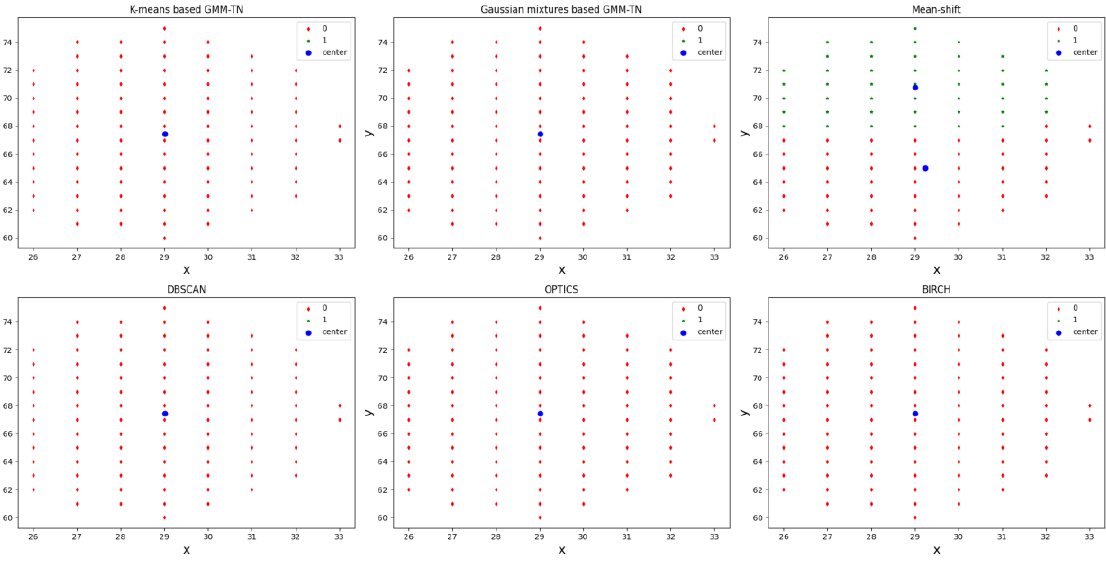
Figure 17. Automatic target number estimation results (double overlapped targets) using K-means- based GMM-TN, Gaussian-mixtures-based GMM-TN, Mean-shift, DBSCAN, OPTICS, and BIRCH. According to the two cases results, we find the GMM-TN algorithm developed in this paper can provide accurate automatic target numbers, either using the K-means or the Gaussian mixtures clustering. Their centroids are somewhat different. However, the Mean-shift and BIRCH algorithms tend to cluster single target into multiple targets, which will lead to a false detection problem. In contrast, the DBSCAN and OPTICS algorithms tend to cluster double targets into single target, which will lead to a missed detection problem. From the graph signatures of spatial distribution shape, the single target ConfMap generated by RODNet usually satisfies the elliptic hypothesis. For two adjacent targets, their spatial distribution of ConfMap can be modeled as two ellipses overlapping to- gether. We believe that this is related to the FFTs operation used in radar RA map pro- cessing and the CNN-based RODNet. This kind of spatial distribution shape feature